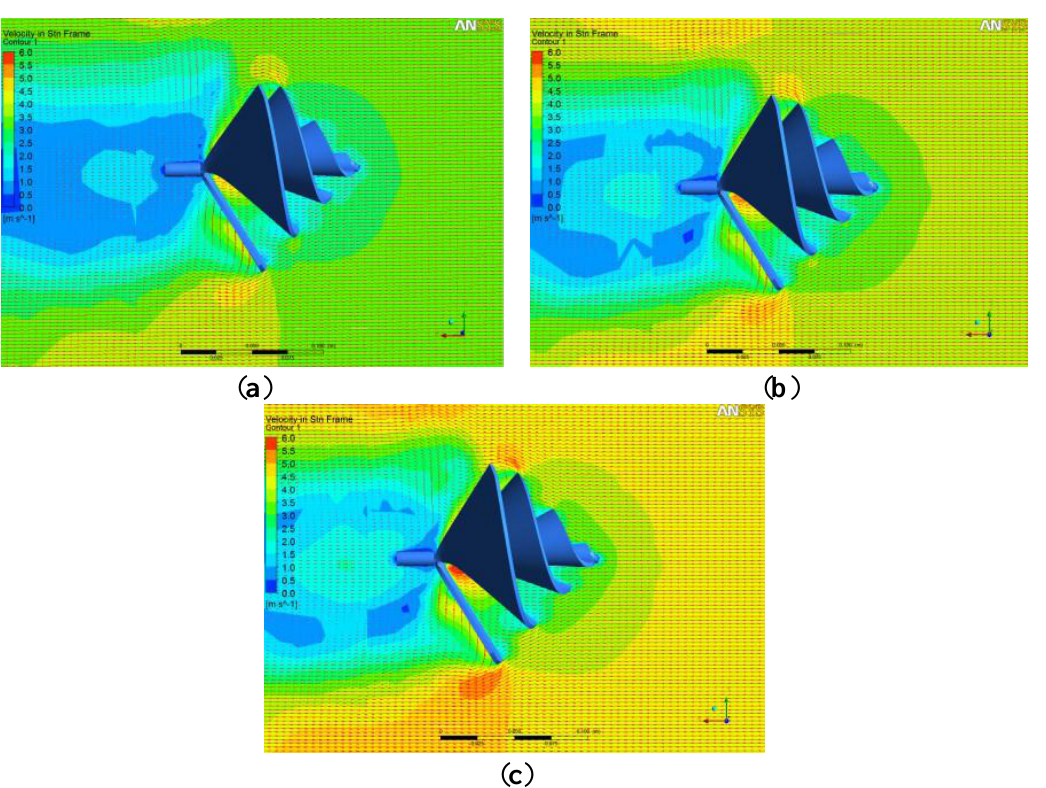
Figure 8. Ensemble-averaged velocity fields obtained by the steady simulation: ( a ) 3.5 m/s and 300 rpm; ( b ) 4 m/s and 400 rpm; ( c ) 5 m/s and 500